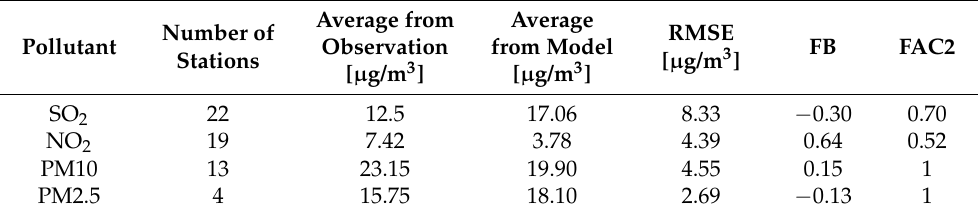
Table 8. Evaluation of the modelled result against measurements of the annual average